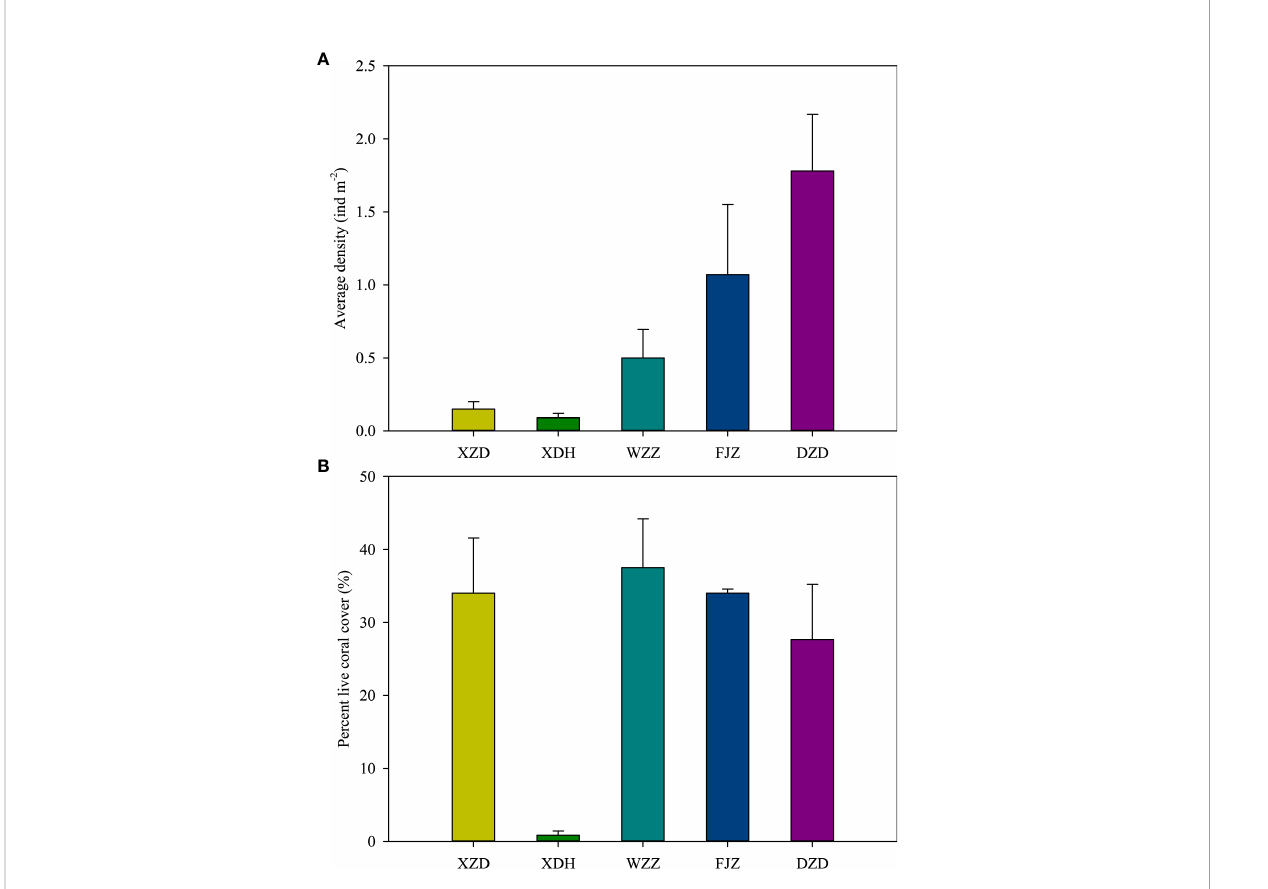
FIGURE 2 Spatial differences in (A) average snail density and (B) average percent live coral cover for each station. Bars indicate standard